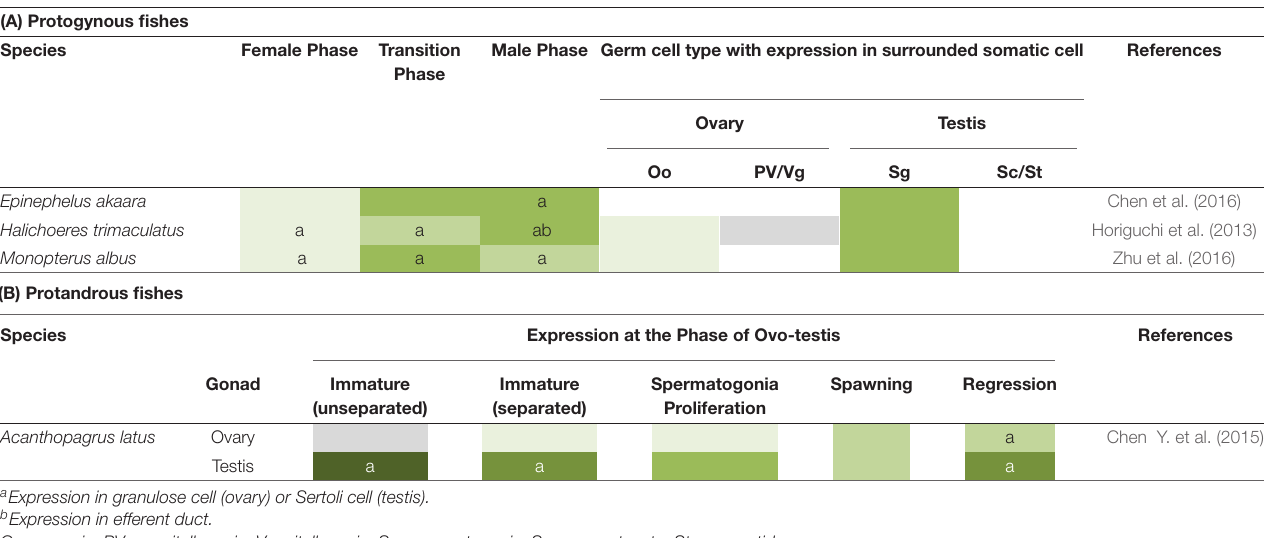
TABLE 2 | Expression of gsdf in hermaphroditic